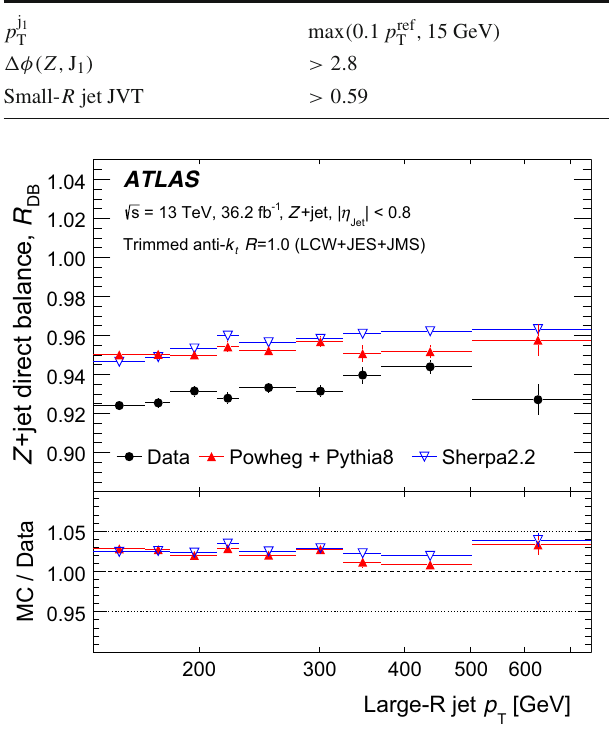
Table 2 Summary of the 2 → 2 topology selection and systematic variations considered for the Z +jet direct balance analysis. The labels J i refer to the i th leading large- R jet, and j i to the i th leading small- R jet that fulfils (cid:4) R ( J 1 , j i ) > 1 . 4 Variable